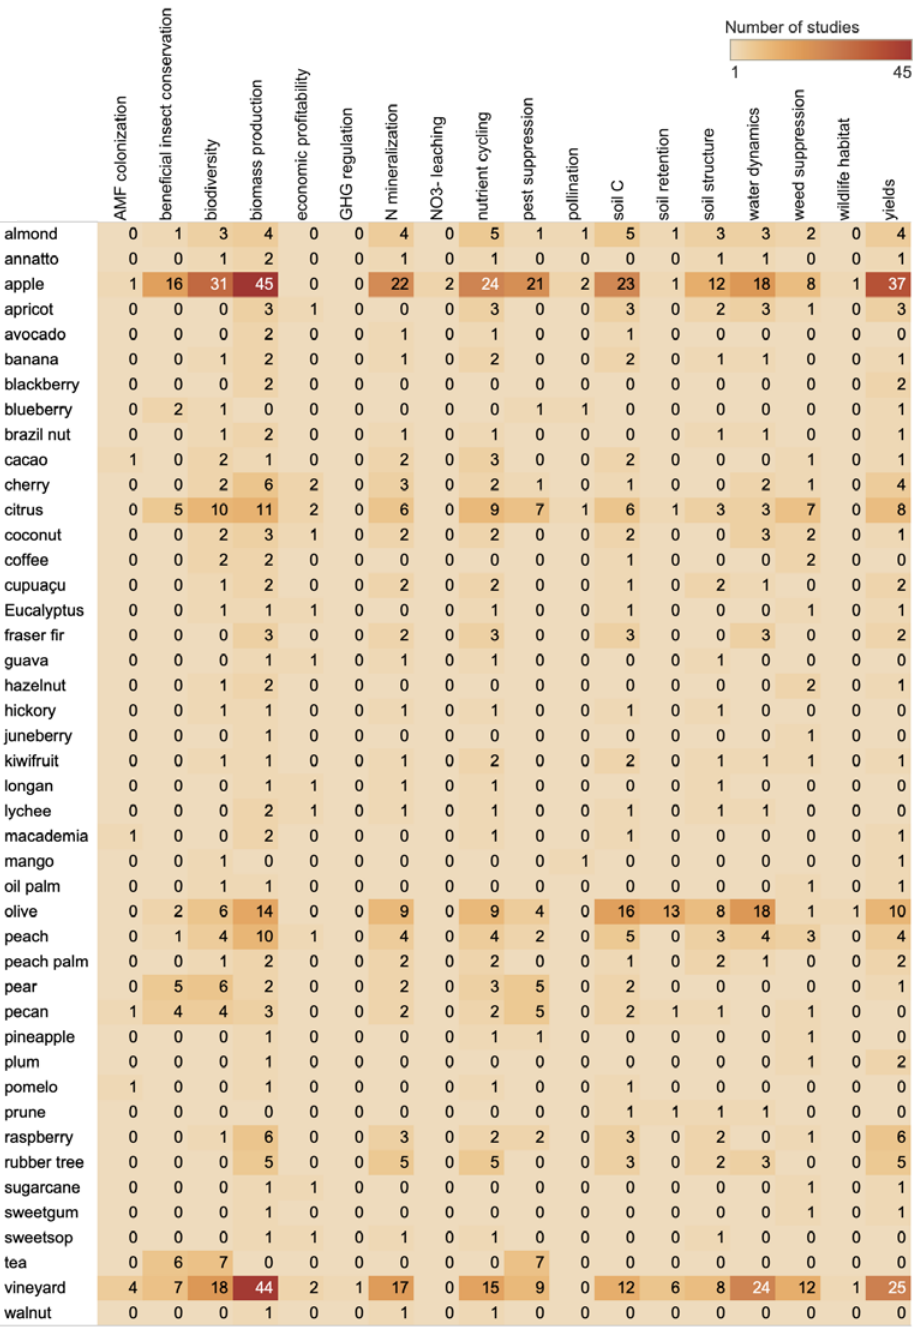
Figure 4. Research coverage of ecosystem services distinct to perennial cropping systems in the comprehensive cover crop literature.